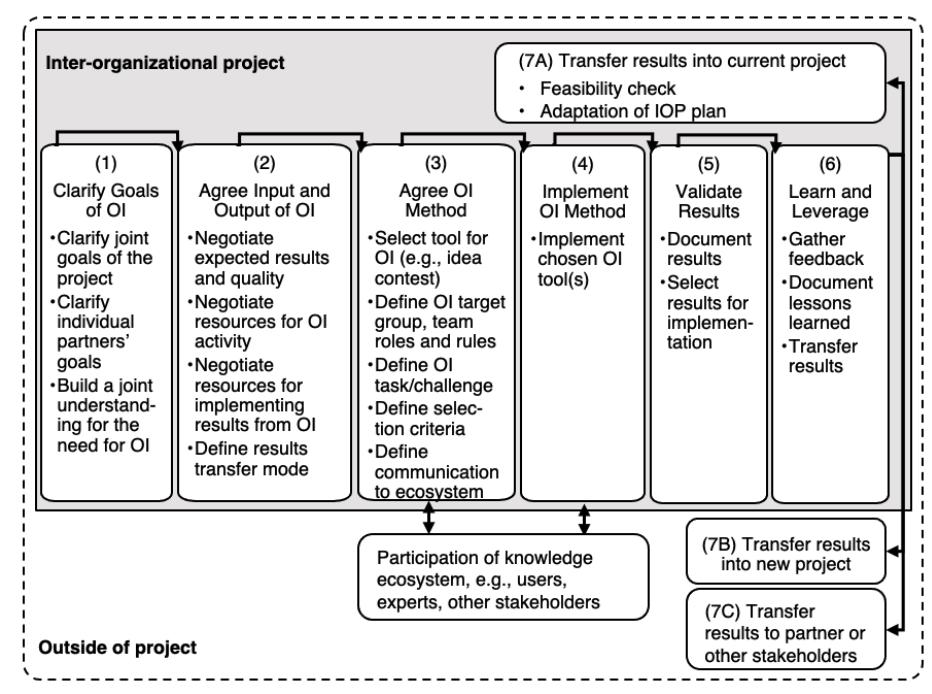
Figure 4. Adjusted Open Innovation process for inter-organizational